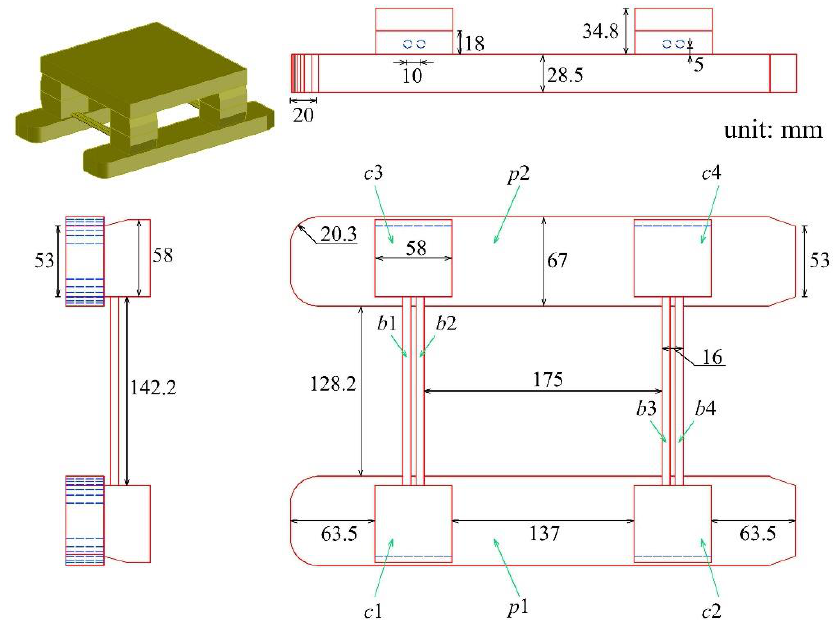
Figure 3. The dimensions of the semi-submersible platform.